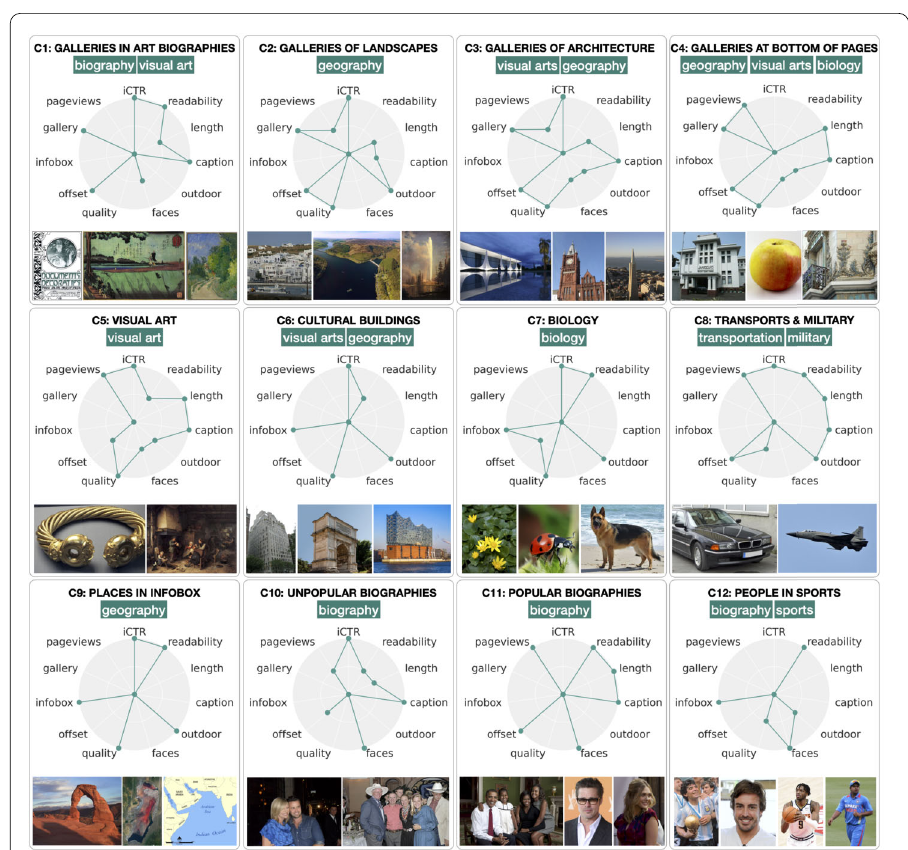
Figure 10 Visual representation of the clustering. The radar plots show for a group centroid the intensity of each feature on a three classes scale. We summarize in green the topics that cover at least 85% of the images categories in a